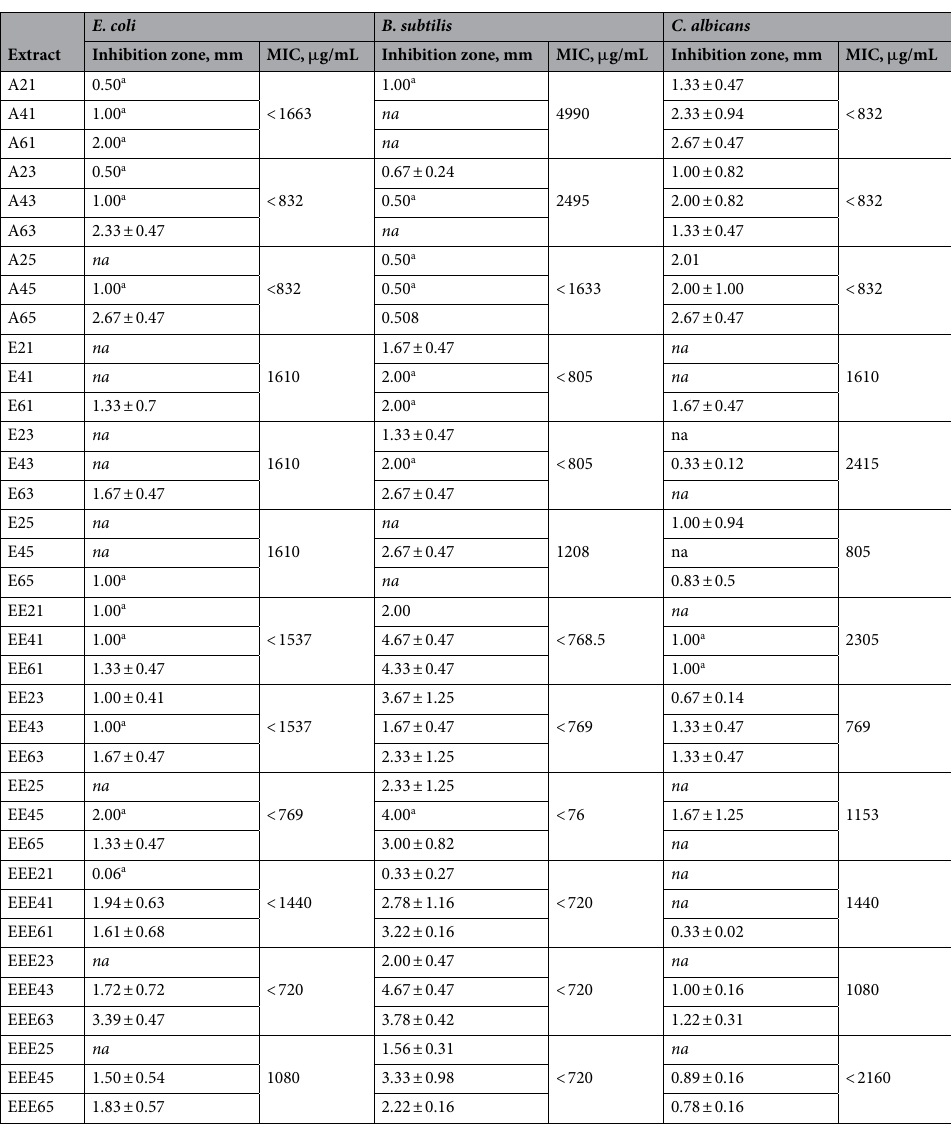
Table 2. The antimicrobial activity of propolis extracts. na non active (no areas of inhibition reported). a identical replicates. E. coli Escherichia coli. B. subtilis Bacillus subtilis spizizenii nakamura. C. albicans Candida